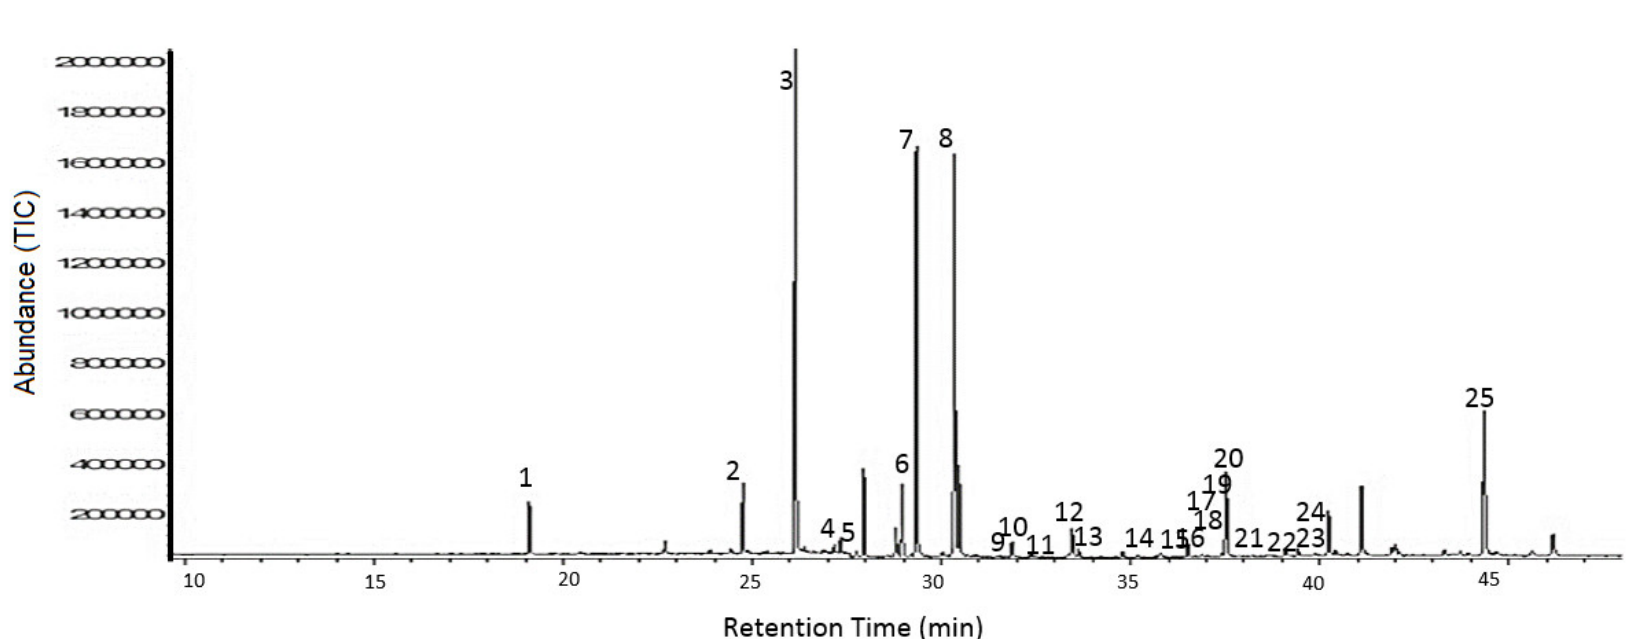
Figure 1. GC-MS detection of brain fatty acids. A typical total ion chromatogram (TIC) of fatty acid methyl esters (FAMEs) from post-mortem brain tissue. The peaks were identified as 1. lauric acid, 2. pentadecanoic acid, 3. palmitic acid, 4. palmitoleic acid, 5. heptadecanoic acid, 6. cis -10-heptadecanoic acid, 7. stearic acid, 8. oleic acid, 9. linolelaidic acid, 10. linoleic acid, 11. arachidic acid, 12. cis -11-eicosanoic acid, 13. linolenic acid, 14. heneicosanoic acid, 15. cis -8,11,14-eicosatrienoic acid, 16. erucic acid, 17. cis -11,14,17-eicosatrienoic acid, 18. cis -11,14-eicosadienoic acid, 19. behenic acid, 20. arachidonic acid, 21. tricosanoic acid, 22. cis -13,16-docosadienoic acid, 23. lignoceric acid, 24. nervonic acid, 25. docosahexaenoic acid.